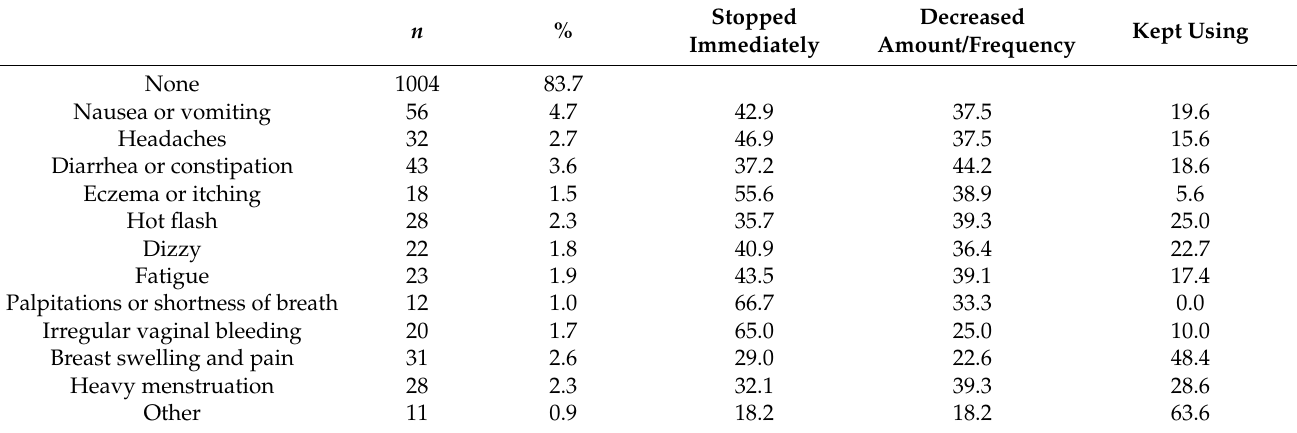
Table 13. Adverse events that might be associated with estrogen-like supplement